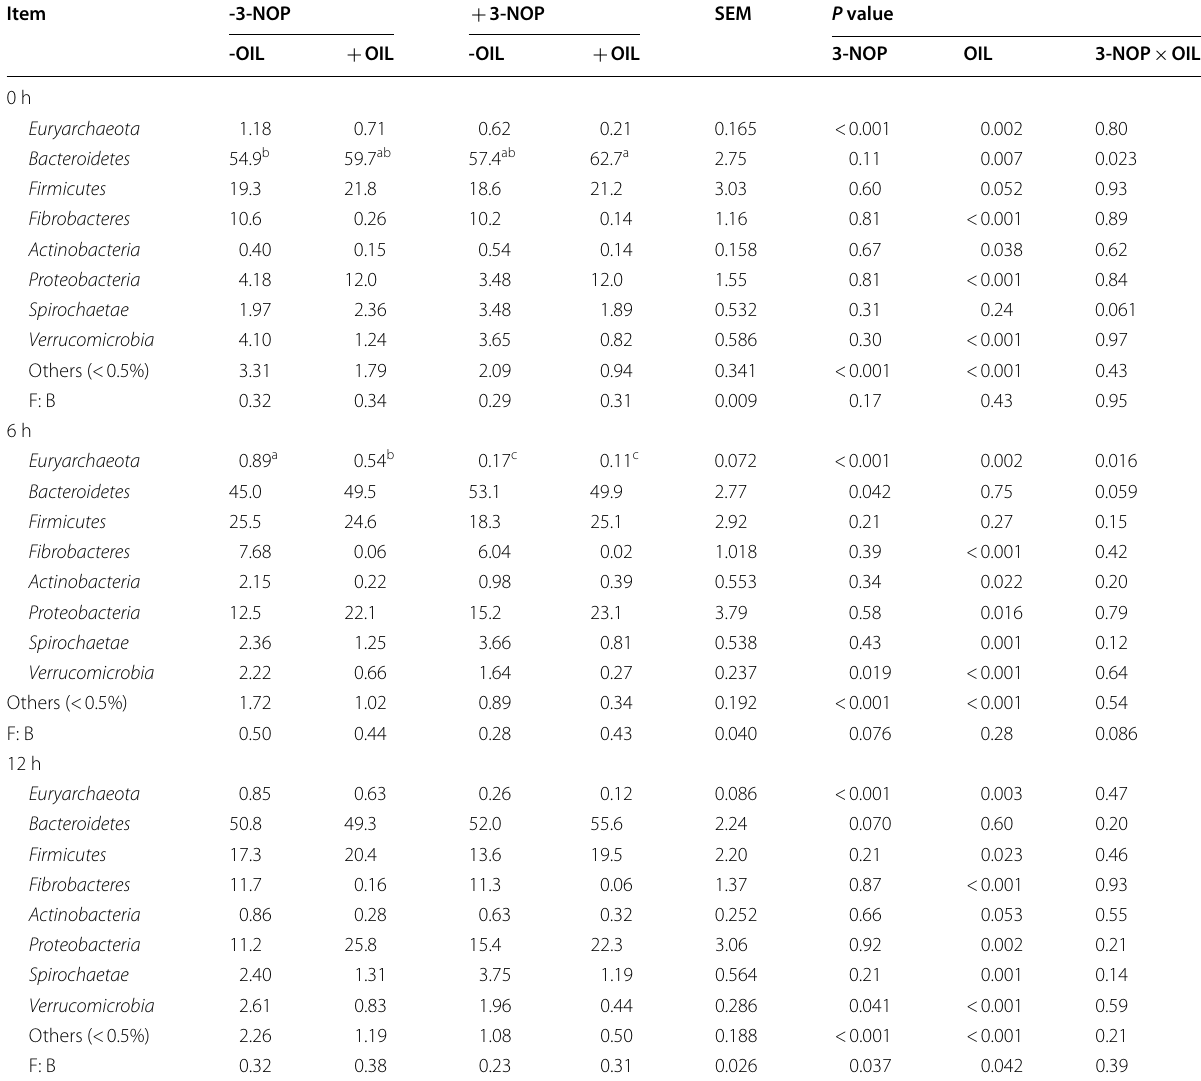
Table 2 Impact of feeding diets supplemented with ( in rumen fluid in beef